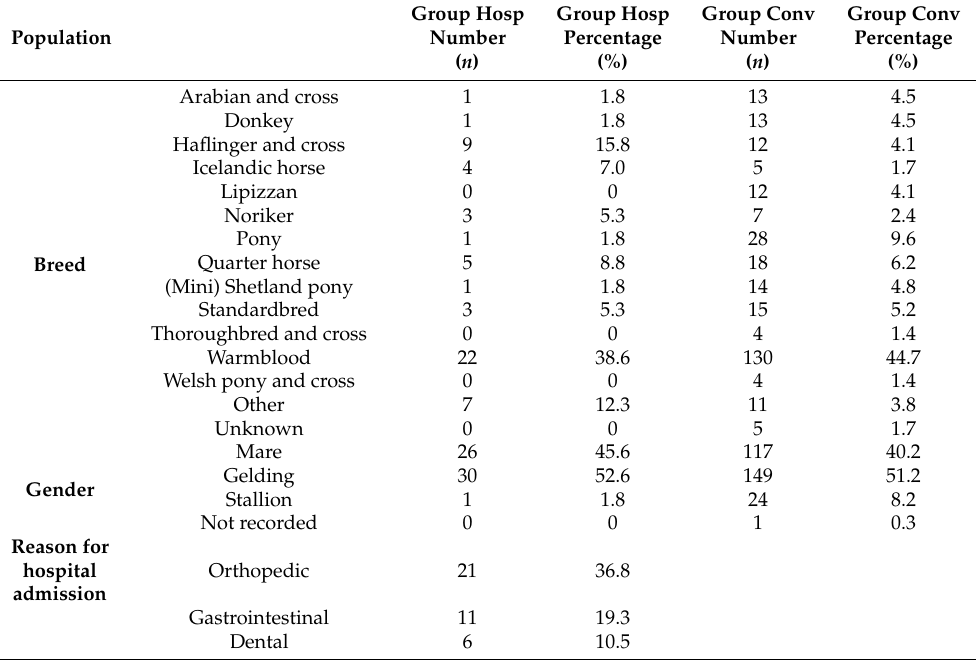
Table 1. Overview of the study population: hospitalized (hosp; total 57) and convenience field sampled (conv; total, 291) equids distributed by breed and gender (hosp and conv) as well as reason for admission